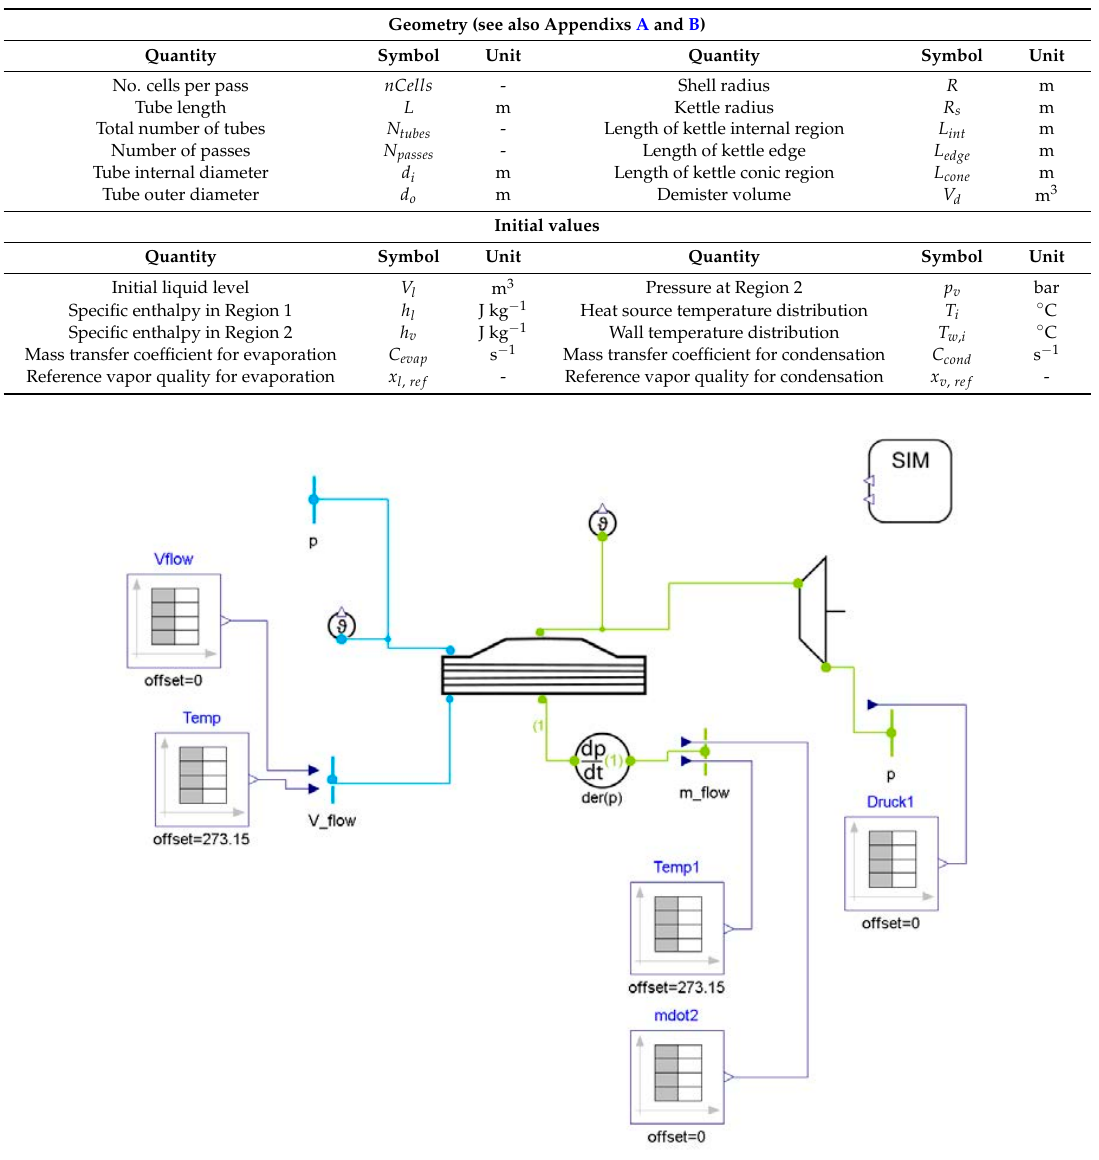
Figure 9. Kettle boiler: simulation layout.